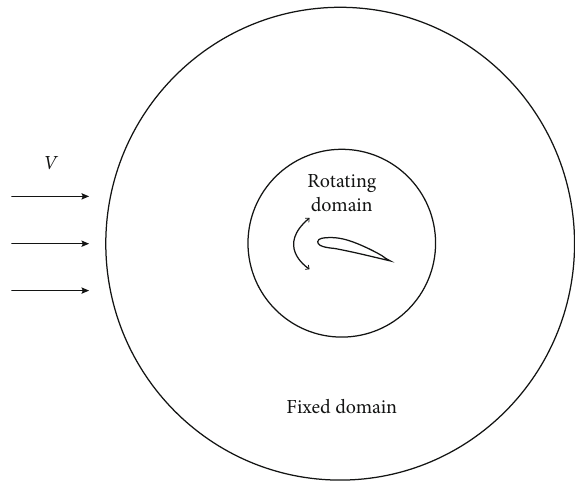
Figure 1: The schematic diagram of the computational domain of the sliding mesh technique.